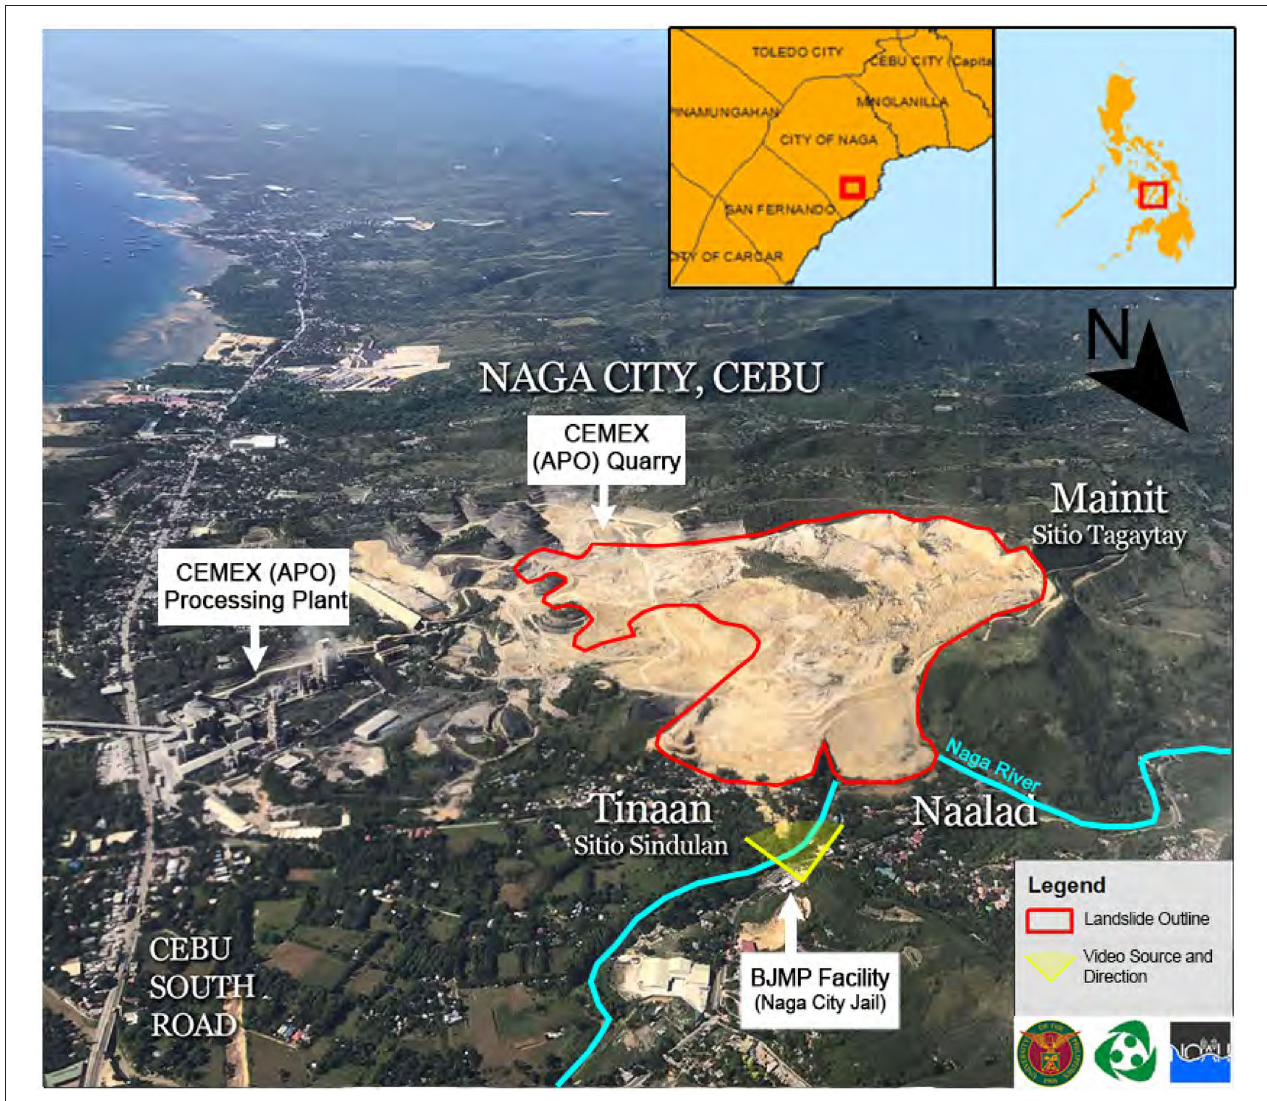
FIGURE 1 | Aerial image of the Naga landslide taken a month after the incident. Numerous houses in Sitio Sindulan, Barangay Tinaan and the village situated near the base of the cliff in Barangay Naalad were buried by the landslide